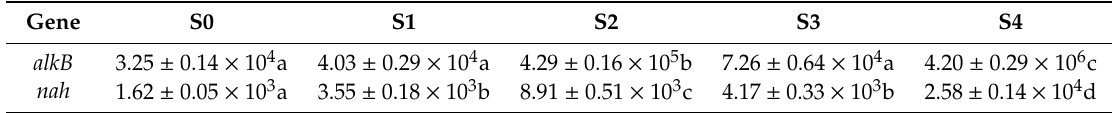
Table 5. Abundance of the alkB and nah genes (copies per g dry